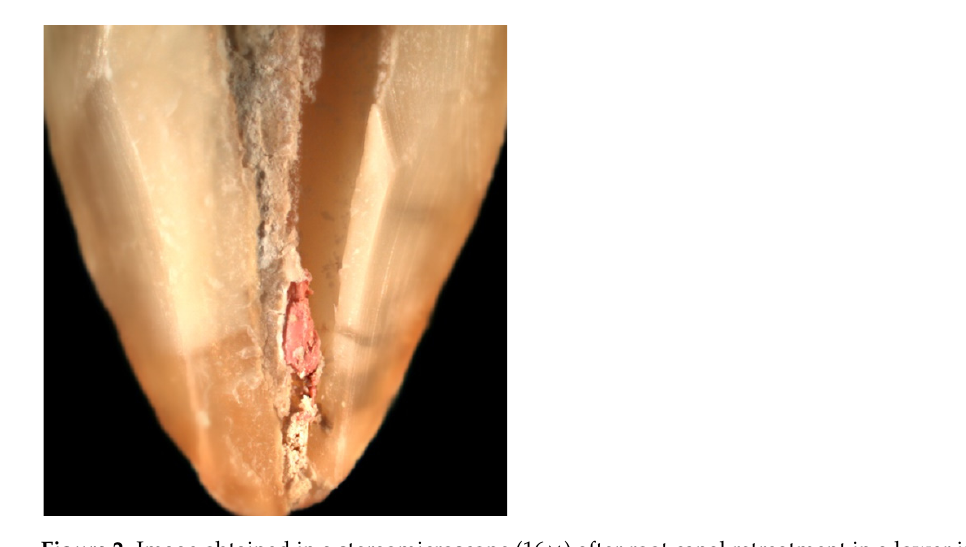
Figure 1. Microcomputed tomographic images of the apical segment of a mesial inferior molar root (class II of Vertucci, with isthmus) subjected to retreatment. Left , initial microtomographic scan performed after root canal obturation. Middle , post ‐ preparation image obtained after retreatment with the Mtwo system (final instrument 35/0.04) in both canals. Right , final image after using the XP ‐ Endo Finisher R.